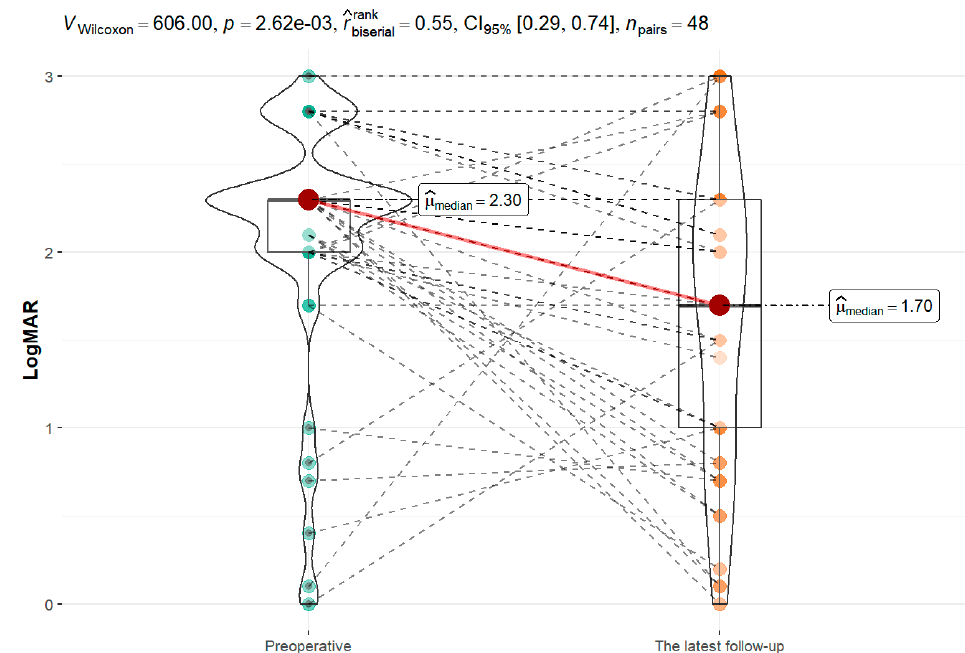
Figure 4. Visual outcomes before and after keratoplasty.